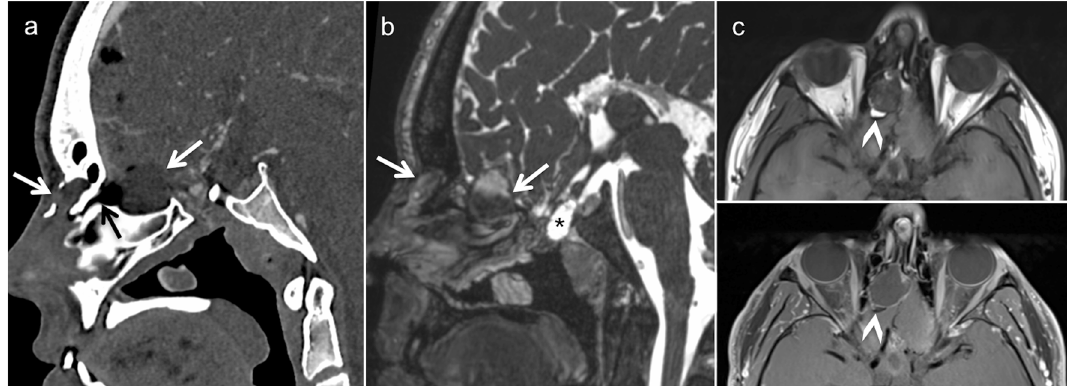
Fig. 9 Nasal dermoid sinus cyst (NDSC) visible since birth in a 15-year- old boy. a Sagittal contrast-enhanced CT scan (soft tissue windows) shows the extra- and intracranial dermoid cysts ( white arrows ), which connect with each other via the abnormal foramen caecum ( black arrow ). b High- resolution sagittal T2 shows that the cystic lesions have different signal